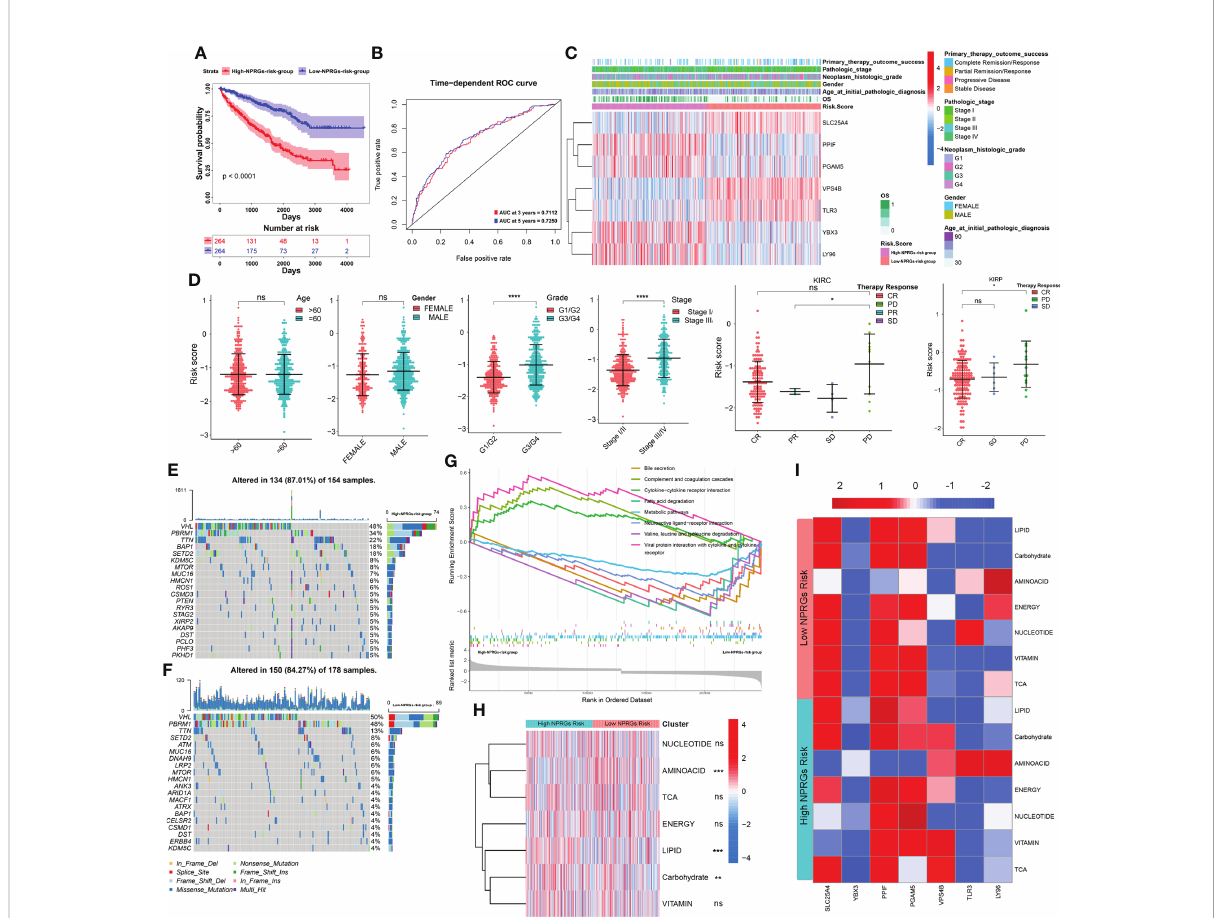
FIGURE 4 Analysis of clinical relevance, somatic mutation, mechanisms, and metabolism reprogramming based on the NPRGss-risk signature. (A – C) The Kaplan – Meier survival curves, ROC curve, and heatmap based on the NPRGs risk signature. (D) The comparison of the gender, age, stage, grade, and therapy response in the high- or low-NPRGs-risk group. (E, F) The waterfall diagram shows the somatic mutation situation of the top 20 genes in the high- or low-NPRGs-risk group of the TCGA-KIRC cohort. (G) GSEA-enrichment plot of top 10 KEGG pathways. (H) Heatmap shows the activity of seven metabolic signatures in the high- or low-NPRGs-risk group of the TCGA-KIRC cohort. (I) Heatmap displays the correlation between NPRGss and seven metabolic signatures in the high- or low-NPRGs-risk group of the TCGA-KIRC cohort, respectively. *p-value < 0.05, **p-value < 0.01, ***p-value < 0.001, ****p-value <